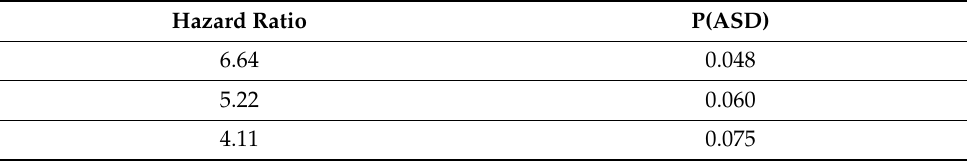
Table 6. P(ASD) for 95% range of hazard ratio with P(ASD|AN) of 0.25.